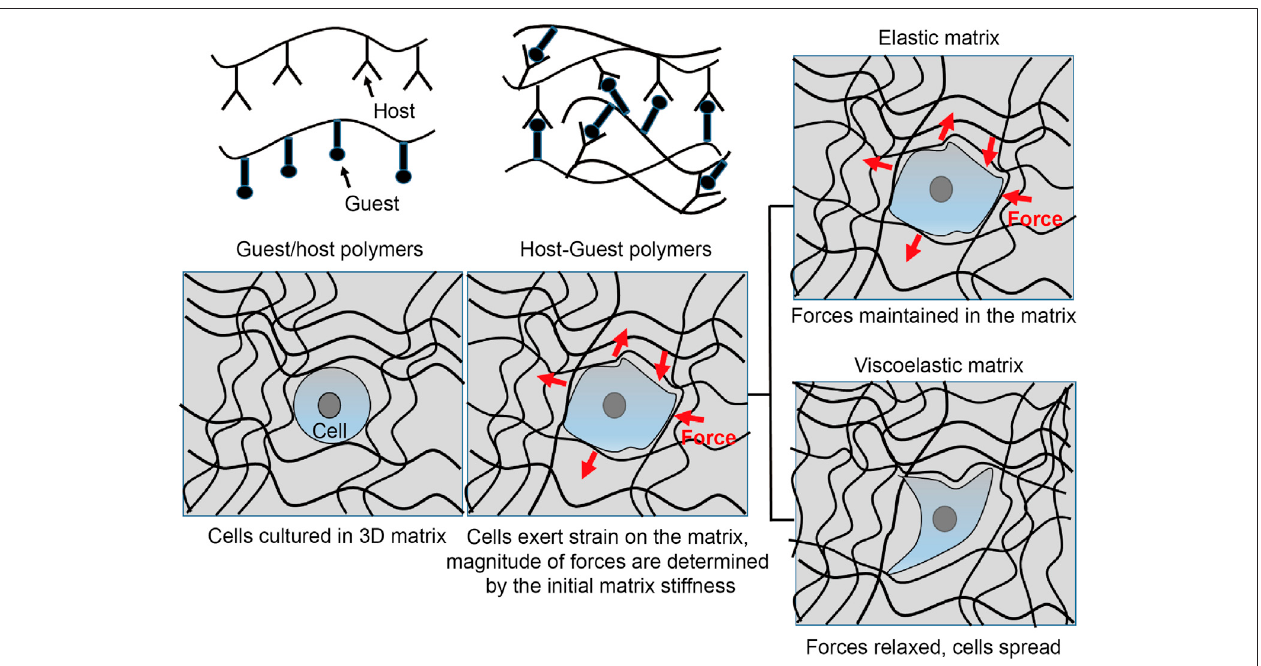
FIGURE 3 | Interrogating cell function by mechanosensing. Non-covalently crosslinked biomaterials can be engineered to interrogate cell fate by mechanotransduction. Such materials can be designed by installing functional moieties on the individual polymer chains to provide shear-thinning and self-healing characteristics. Once cultured in the elastic or viscoelastic cell substrates, cells can experience different mechanotransduction. In a purely elastic substrate, the cells probe the matrix via integrins and possess spherical shape. On the other hand, if they are cultured on a viscoelastic substrate, both the elastic and viscoelastic components of the matrix can regulate the cell function. Consequently, the cell-mediated forces can be relieved or dissipate in the viscoelastic matrix. The cells can also deform the matrix during spreading, proliferation, and migration.